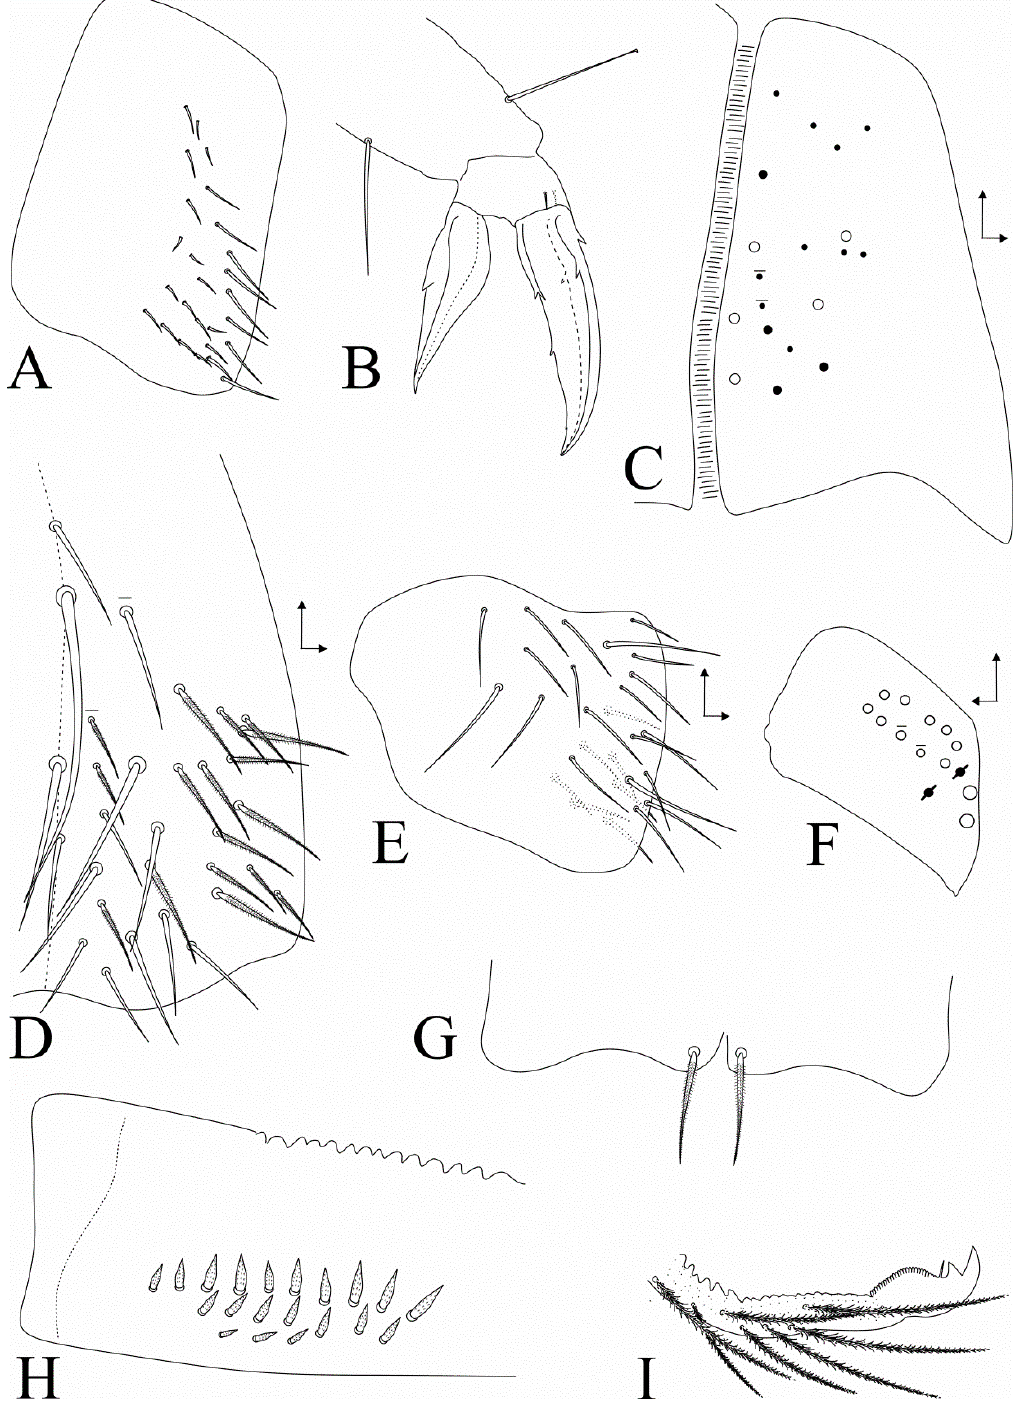
Figure 6. Dicranocentrus abestado sp. nov. trunk appendages: ( A ) trochanteral organ; ( B ) empodial complex of leg. III (anterior view); ( C ) ventral tube anterior face (right side); ( D ) ventral tube posterior face (right side); ( E ) ventral tube lateral flap (right side); ( F ) manubrial plate (left side); ( G ) manubrium ventro-distal chaetae; ( H ) spines on basal dens (internal view of right side); ( I ) distal dens and mucro. Type material: Holotype: Female in slide (CC / UFRN): Brazil, Bahia State, Chapada Diamantina ◦ (cid:48) ◦ (cid:48) National Park, Lenç ó is Municipality (12 33 47” S, 41 23 28” W), Caatinga phytogeographic